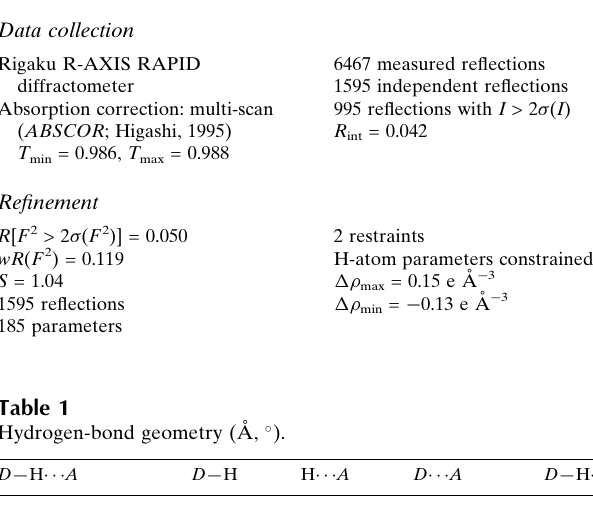
The crystal structure of the title compound,